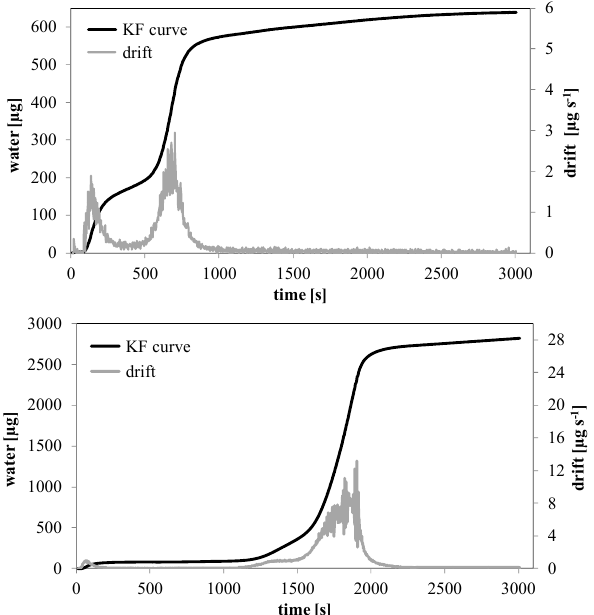
Fig. 3. Karl-Fisher curves of about 50mg of standard materials HYD (upper panel) and WSO (lower panel).